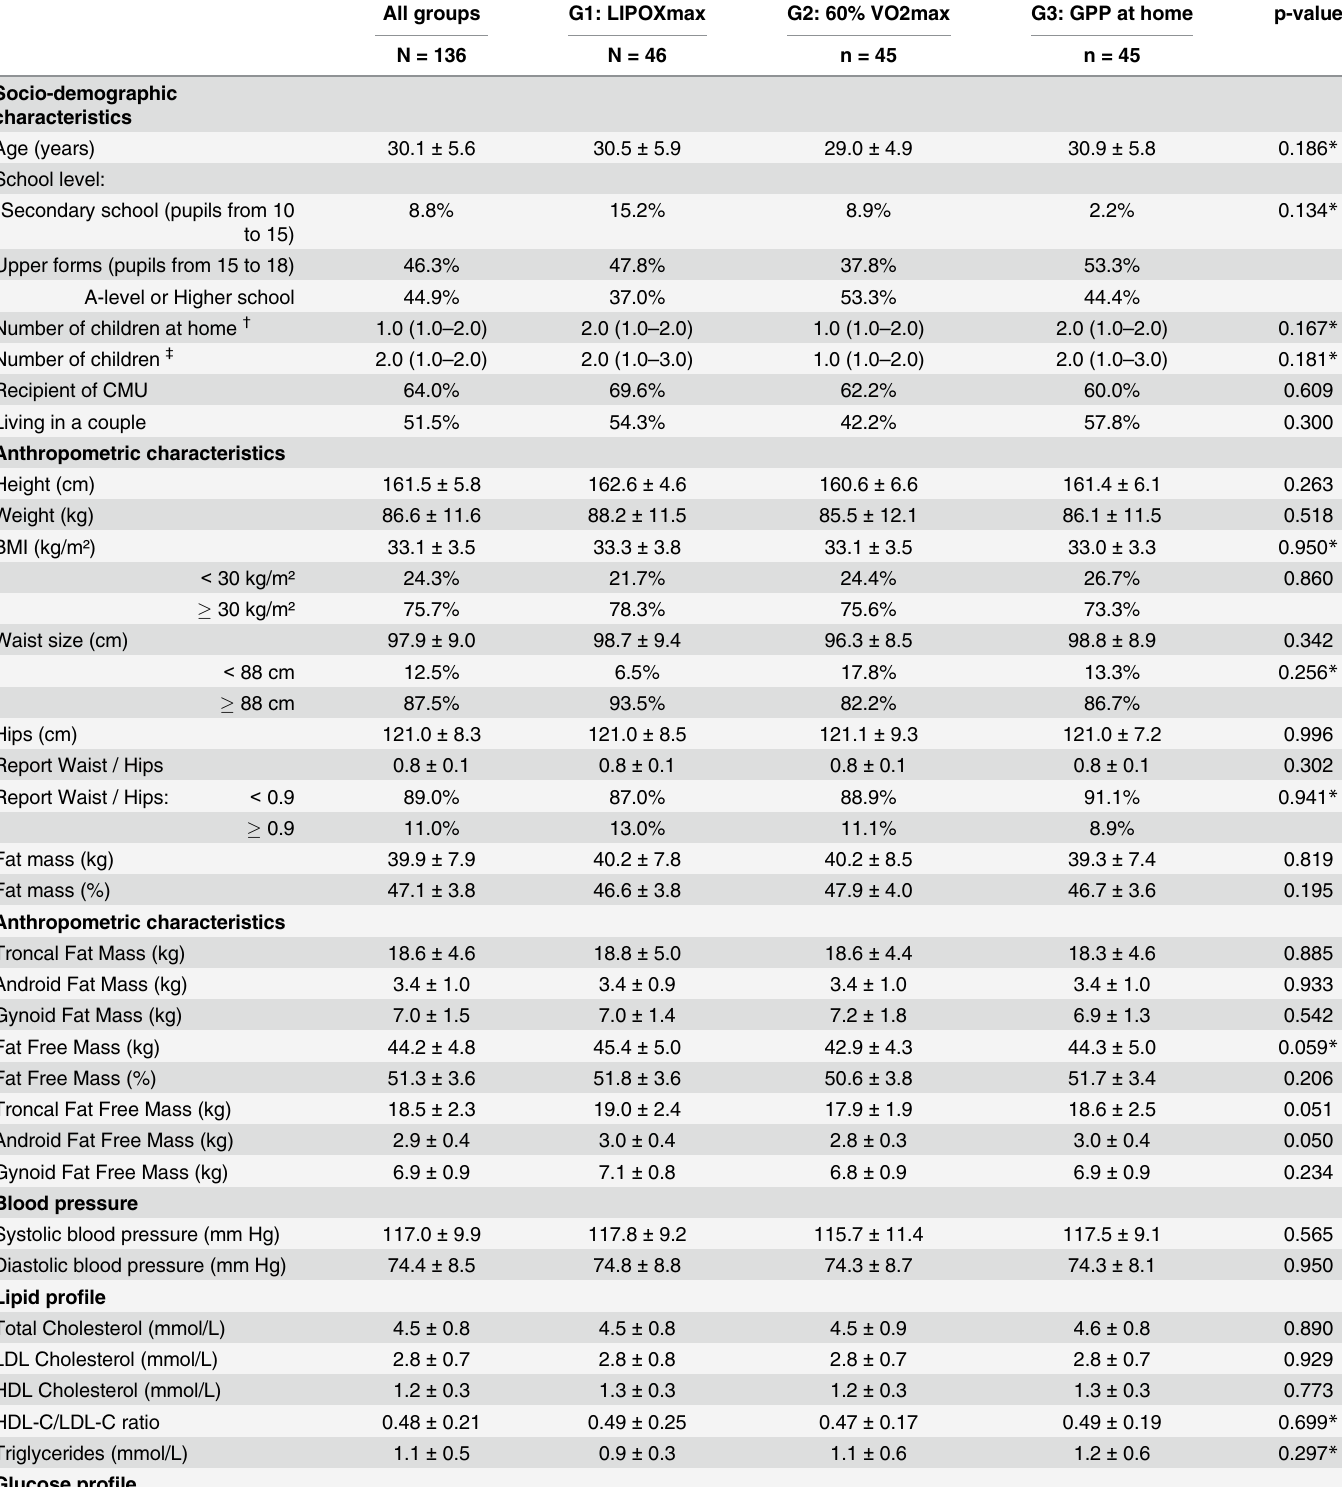
Table 1. Baseline inclusion characteristics for LIPOXmax-Réunion randomized controlled trial